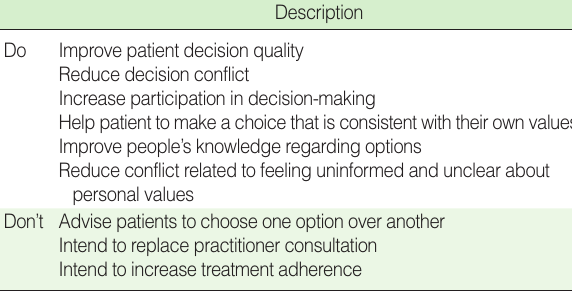
Table 1 outlines the purpose- and application-related usability Table 1. Purposes of developing patient decision aids